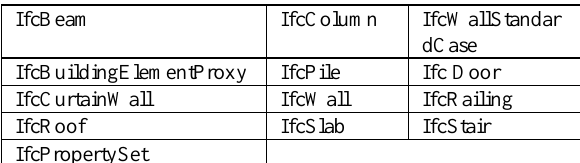
Table 2: IFC classes of the Vent Shaft IFC